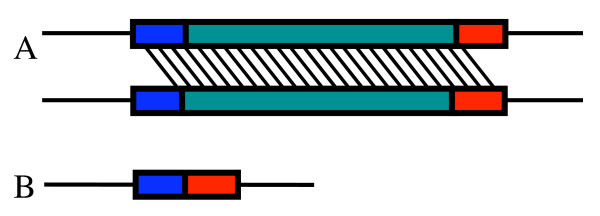
A schematic representation of the repeat removal process. A. Two copies of the protein are shown. Colored area indicates a repeat region. Blue marks the first repeat unit, orange marks the last and green the rest. The diagonal lines mark the alignment that matches the repeat region to itself. The first repeat unit starts with the first aligned position and ends just before the position it aligns to. The last repeat unit ends with the last position aligned and begins right after the position it aligns to. B. The representation of the new sequence, after all but the first and last repeat units are "spliced out". For an extreme example, protein [Swiss-Prot:P08519] that contains 38 units of the Kringle domain, is reduced from 4548 amino acids to 467 amino acids following this step.